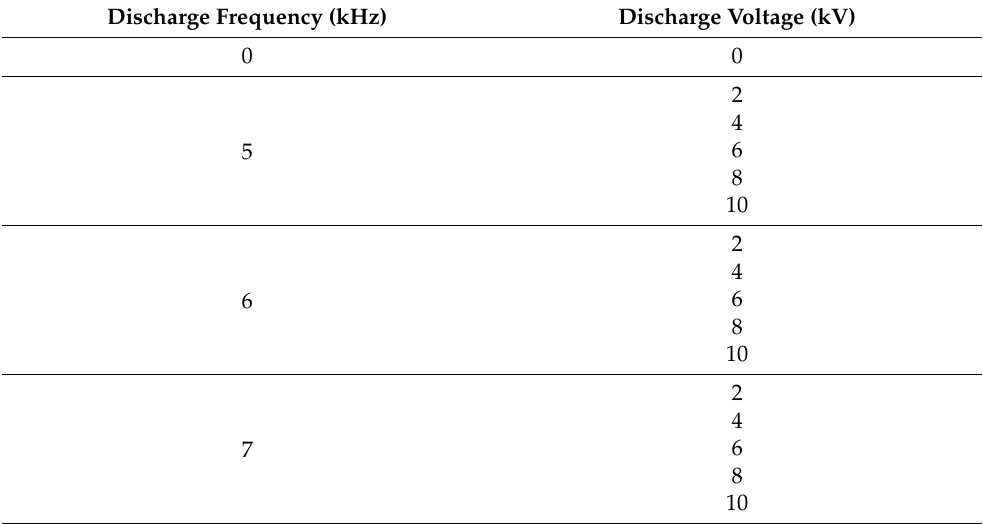
Table 1. Experimental